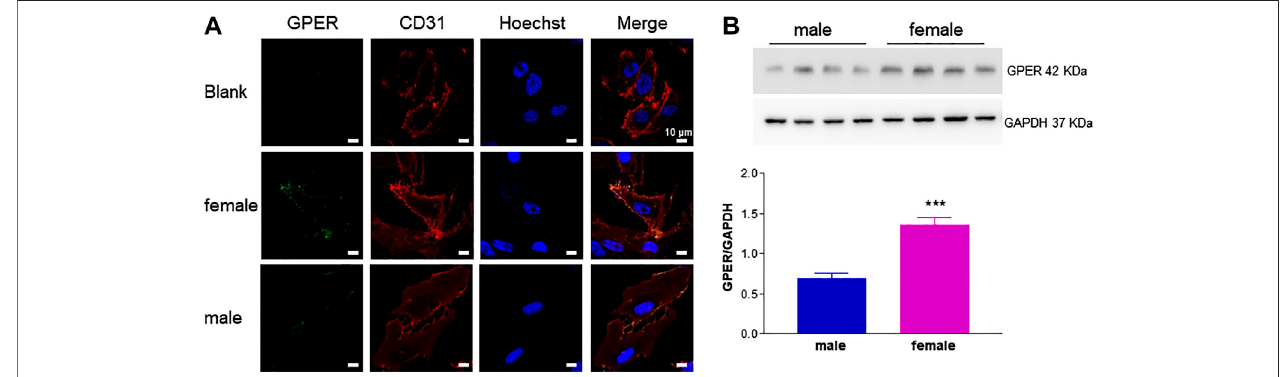
FIGURE2| GPERdetectioninHUVECs fromfemaleand maledonors. A .HUVECswereincubated withanti-GPER andanti-CD31antibodies.Nucleiwerelabeled with Hoechst stain. Images from left to right show subcellular localization of GPER (green), CD31 (red) and cell nuclei (blue), respectively. Blank sample was incubated only with CD31 primary antibody, but with both (green and red) secondary antibodies. Representative confocal images (600 × ); scale bar 10 μ m. (B) . GPER immunodetection. A representative experiment is shown in the upper panel. GAPDH expression was used as loading control. Bands from independent experiments ( n (cid:1) 2) performed using cells from four male and four female donors were quanti fi ed bydensitometric analysis and normalized toGAPDH (mean ± SEM of8 male and 8 female donors). t -test; *** p < 0.001.